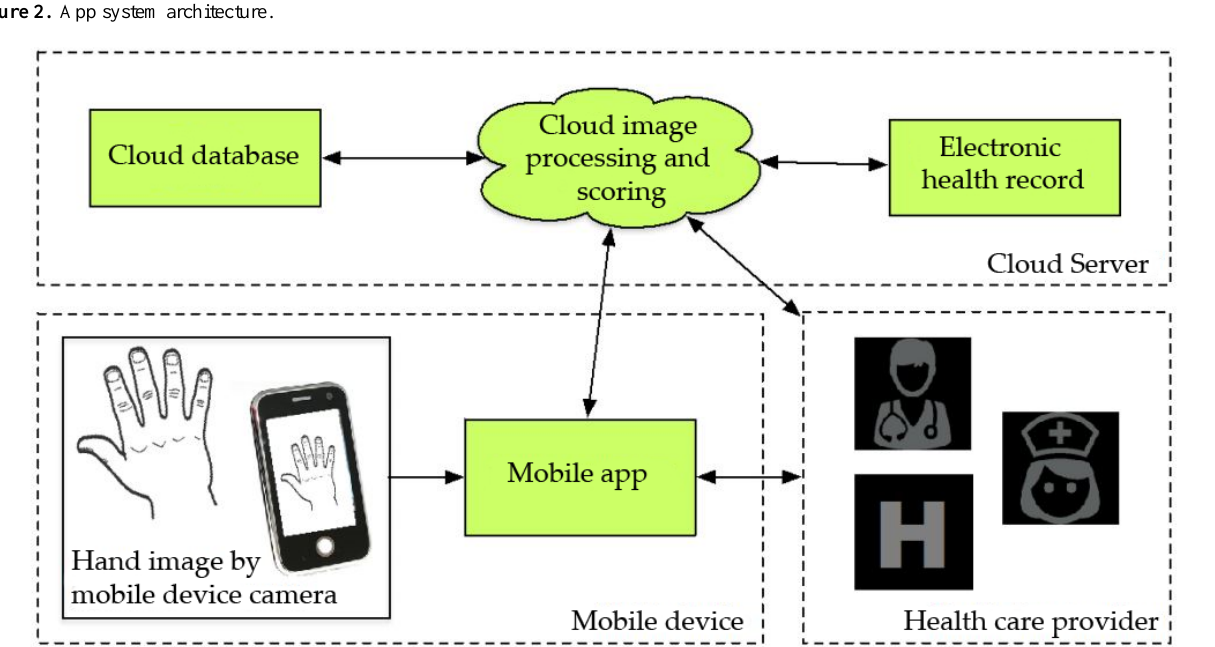
Figure 2. App system